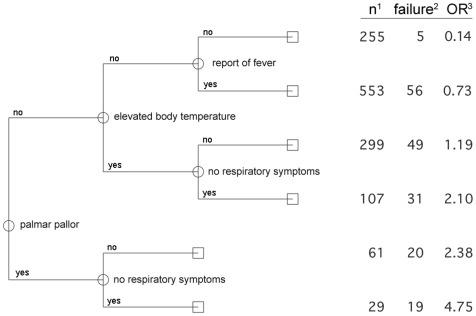
CART – model for children between 2 and 12 months of age (N = 1304).
1 Number of patients with the respective combination of variables given by the branches of the decision tree. 2 Number of patients positive for P. falciparum parasitaemia. 3 Odds Ratio for P. falciparum parasitaemia with the combination of variables in comparison to all other combinations.